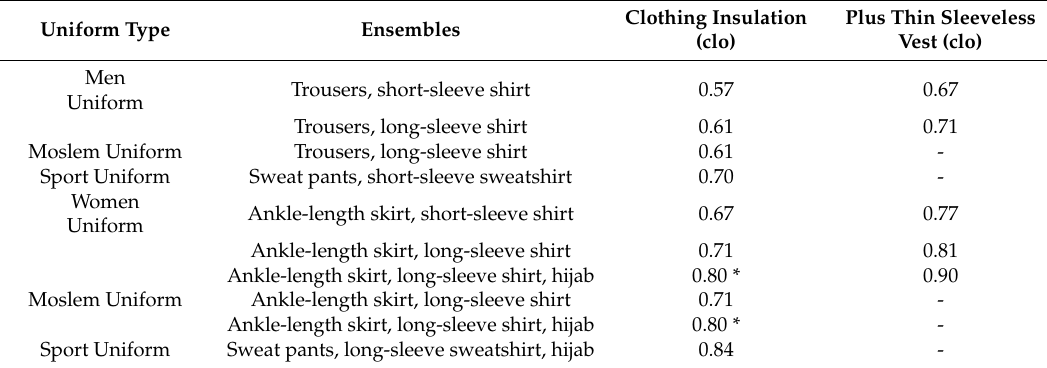
Table 5. The clothing insulation (clo) of ensembles wear by students.